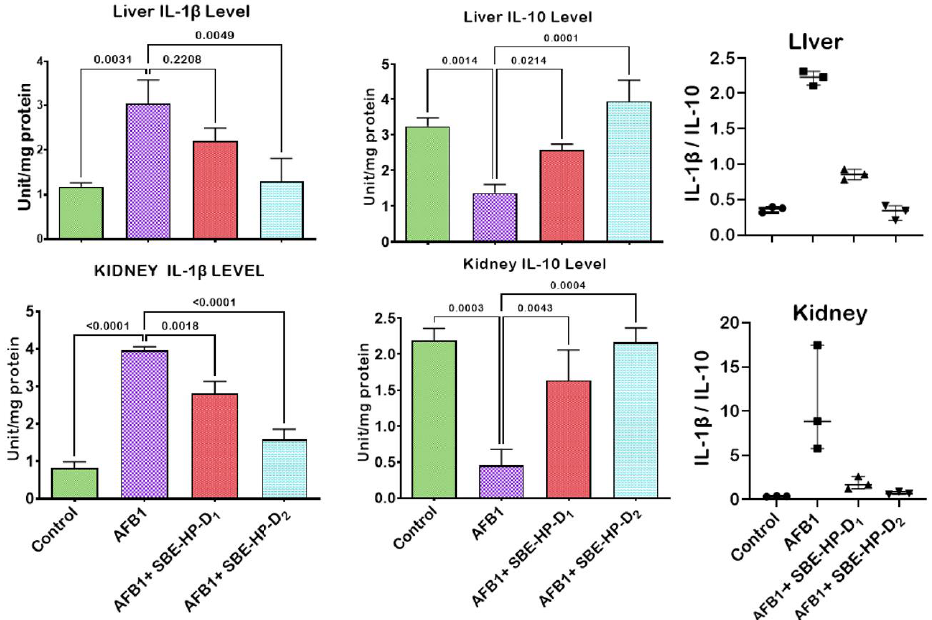
Figure 9. Effect of SBE-HP on tissue concentrations of IL-1 β and IL-10 in the liver and kidney of rats treated with AFB 1 for 28 d. AFB 1 at 50 µ g/kg; SBE-HP-D1 at 5 mg/kg; SBE-HP-D2 at 10 mg/kg. Values are expressed as mean ± SD for six rats per treatment cohort. Connecting lines indicate groups compared to one another. The significance level was set at ( p < 0.05); p < 0.05 suggests the level of significance; p > 0.05: not significant. AFB 1 : Aflatoxin B1; D1: lower dose; D2: higher dose; IL-1 β : Interleukin-1beta; IL-10: